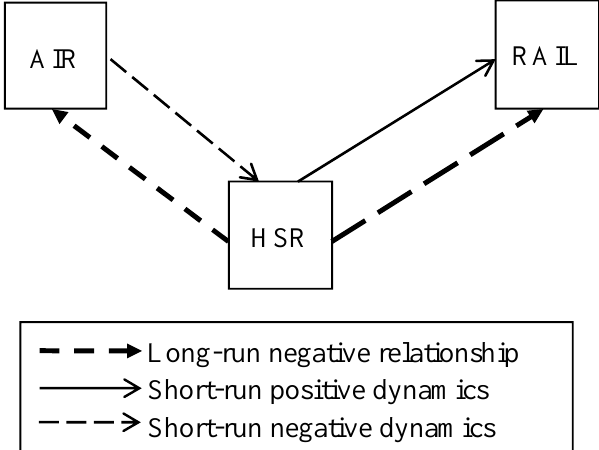
Figure 3. Granger causality relationships between the transport modes.